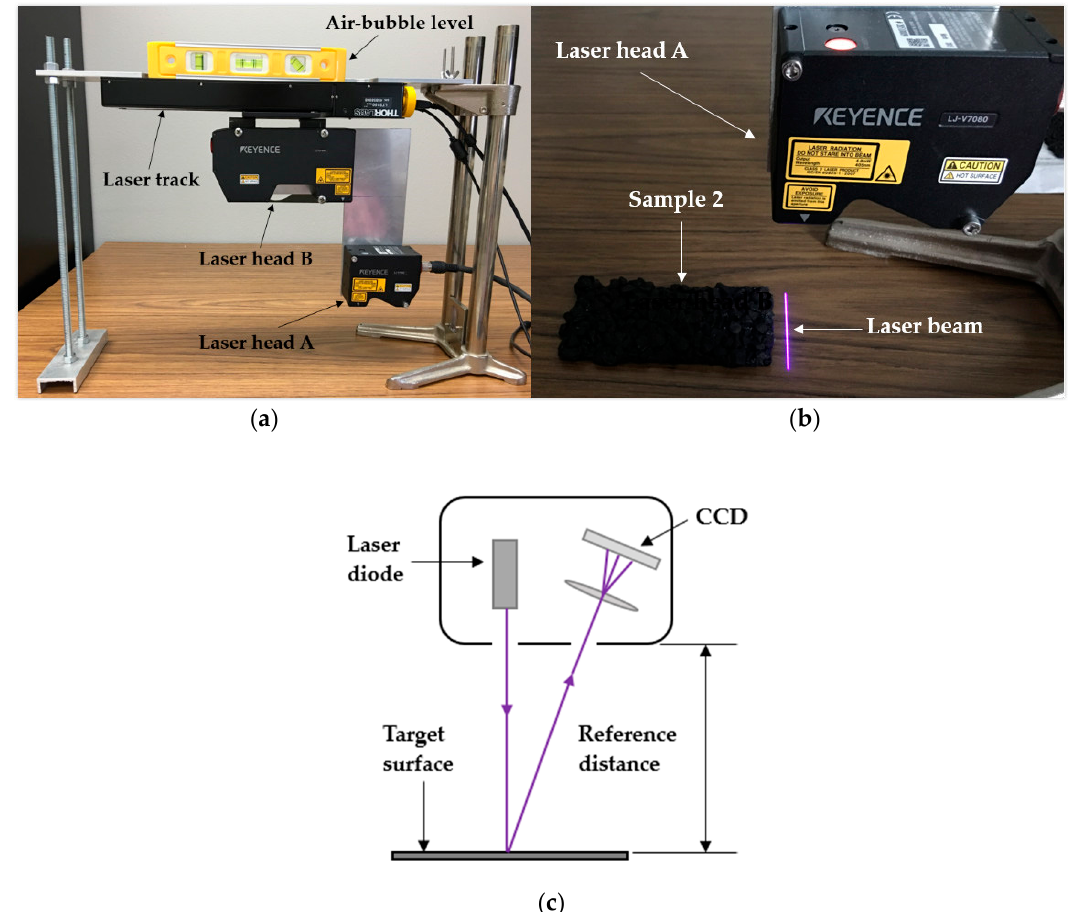
Figure 2. ( a ) The prototype including the frame and mounted lasers; ( b ) scan application with laser head A; ( c ) the triangulation system of a laser [6].